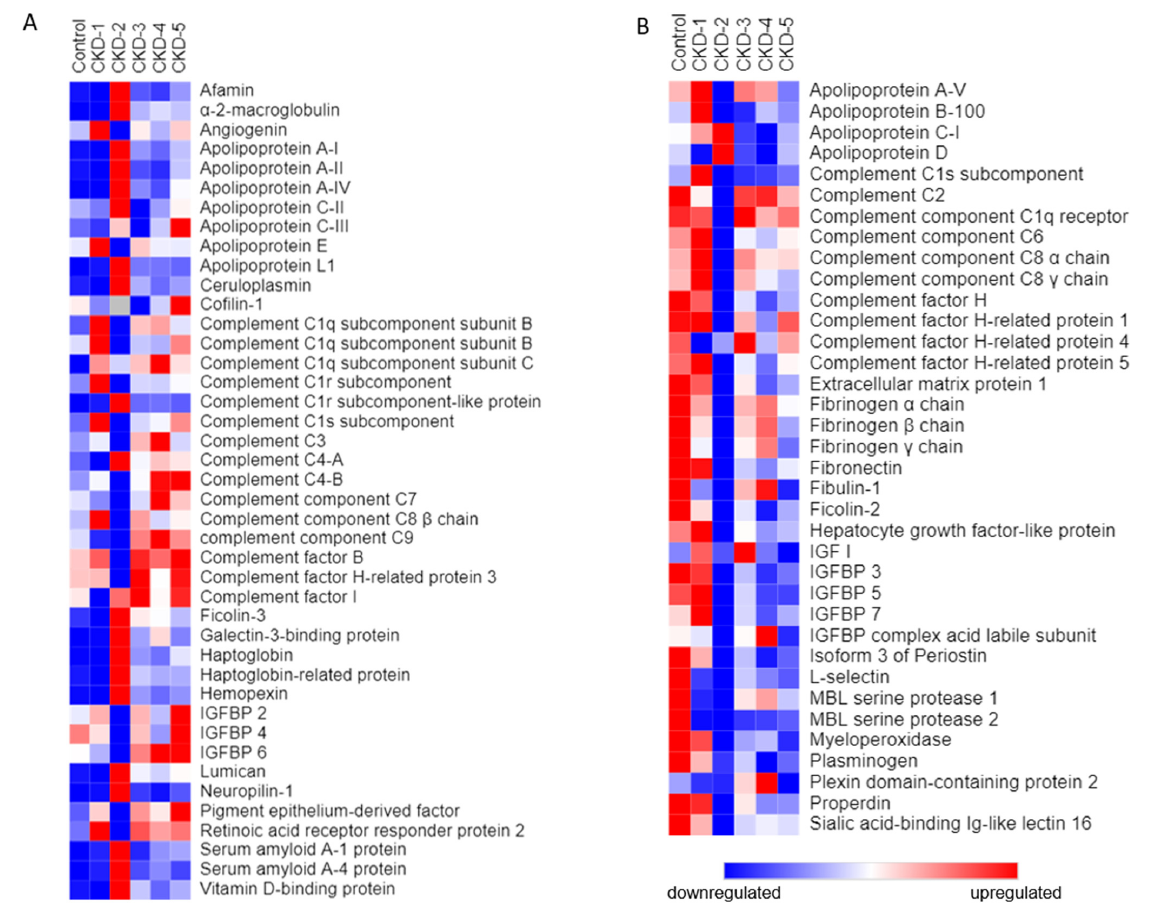
Figure 2. Heatmap showing selected proteins which were observed to generally have: ( A ) an increasing trend through CKD stages 1–5; ( B ) a decreasing trend through CKD stages 1–5.